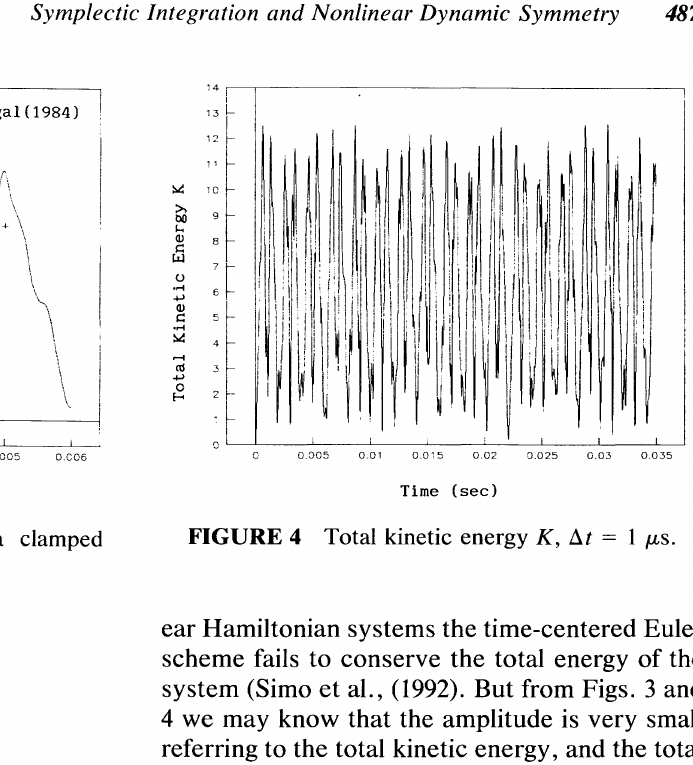
FIGURE 2 Midspan displacement of a clamped beam.